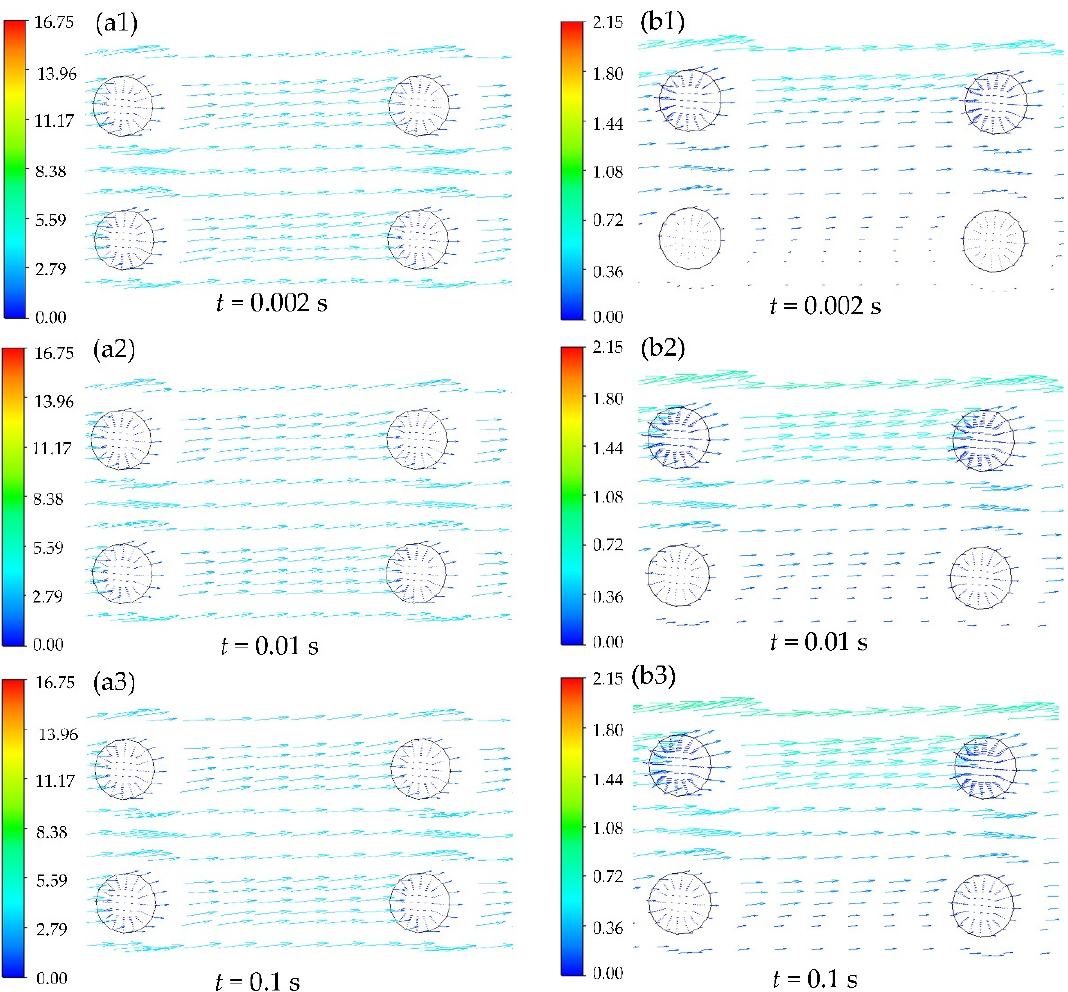
Figure 13. Vector diagram of local oil flow velocity (( a1 ) is velocity vectors of oil when t = 0.002 s; ( a2 ) is velocity vectors of oil when t = 0.01 s; ( a3 ) is velocity vectors of oil when t = 0.1 s; ( b1 ) is velocity vectors of gas when t = 0.002 s; ( b2 ) is velocity vectors of gas when t = 0.01 s; ( b3 ) is velocity vectors of gas when t = 0.1 s).